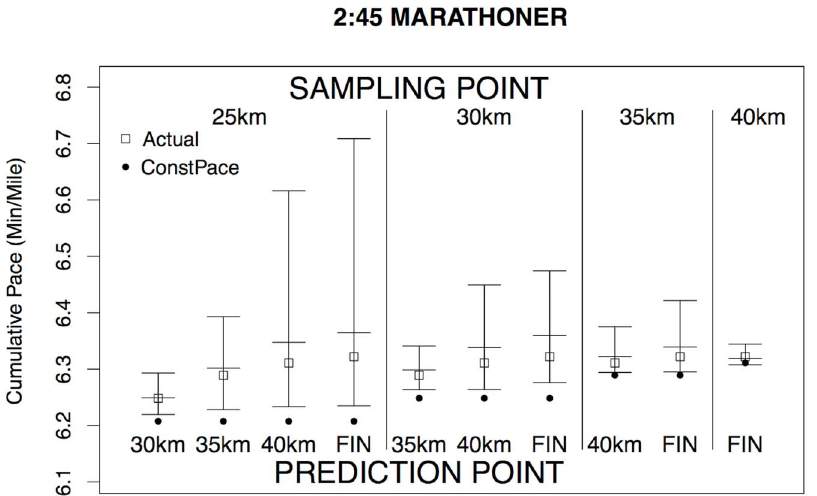
Figure 9. Comparison of Predicted and Actual Pace I. The comparison is made for the 2:45 marathoner depicted in Figure 8. Given the runner’s splits up to a sampling point (one of 25 km, 30 km, 35 km or 40 km), the diagram shows the median prediction (central horizontal line) and the boundary points of a 90% prediction interval (outer horizontal lines) for all subsequent split points. Also shown are the runner’s actual results (open square dots) and the projections assuming Constant Pace (round black dots). All results are presented as net overall pace (minutes/mile), as in Fig. 8.